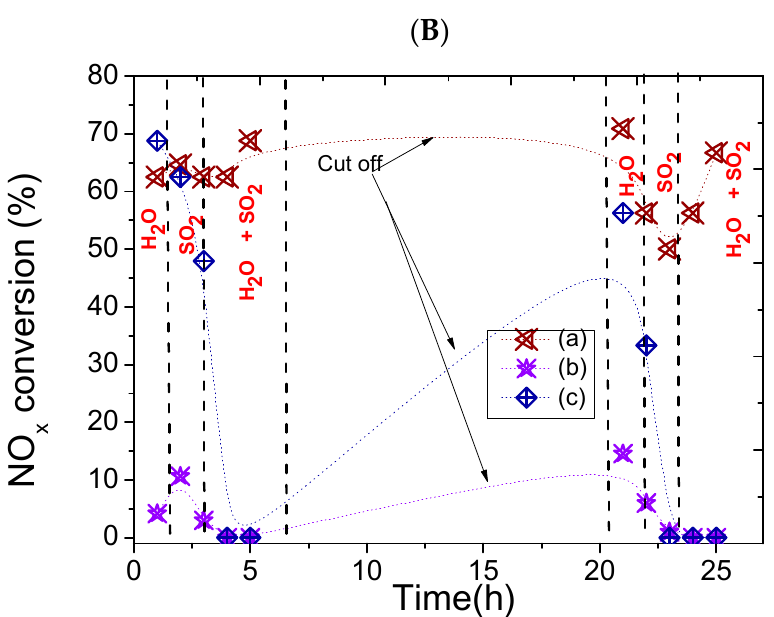
Figure 8. ( A ) CO-SCR performances of catalysts in the presence of distinct poisons. The catalysts studied are as follows: ( a ) CoMo/Nb 2 O 5 , ( b ) PtMo/Nb 2 O 5 , and ( c ) NiMo/Nb 2 O 5 . Reaction conditions: catalyst mass = 150 mg, total flow rate = 80 mL h − 1 , GHSV = 48,000 h − 1 at 350 °C. ( B ) Cutting in and cutting off the poison experiments using the following catalysts: ( a ) CoMo/Nb 2 O 5 , ( b ) NiMo/Nb 2 O 5 , and ( c ) PtMo/Nb 2 O 5 . Reactants composition: 500 ppm of NO, 1000 ppm of CO and balance with He. A 10 wt% (v/v) of water vapor or 50 ppm of SO 2 (or both) was used during the poisoning tests for 24 h. GHSV = 48,000 h − 1 at 350 °C.